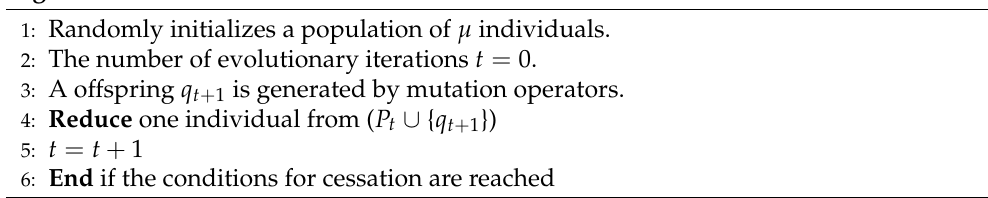
Figure 9. The operation mechanism of the SMS-EMOA algorithm. An offspring is produced in each iteration and evaluated immediately before integration into the next generation of evolution, with poor individuals being eliminated as a new subpopulation. This figure is adopted from [90]. Algorithm 1